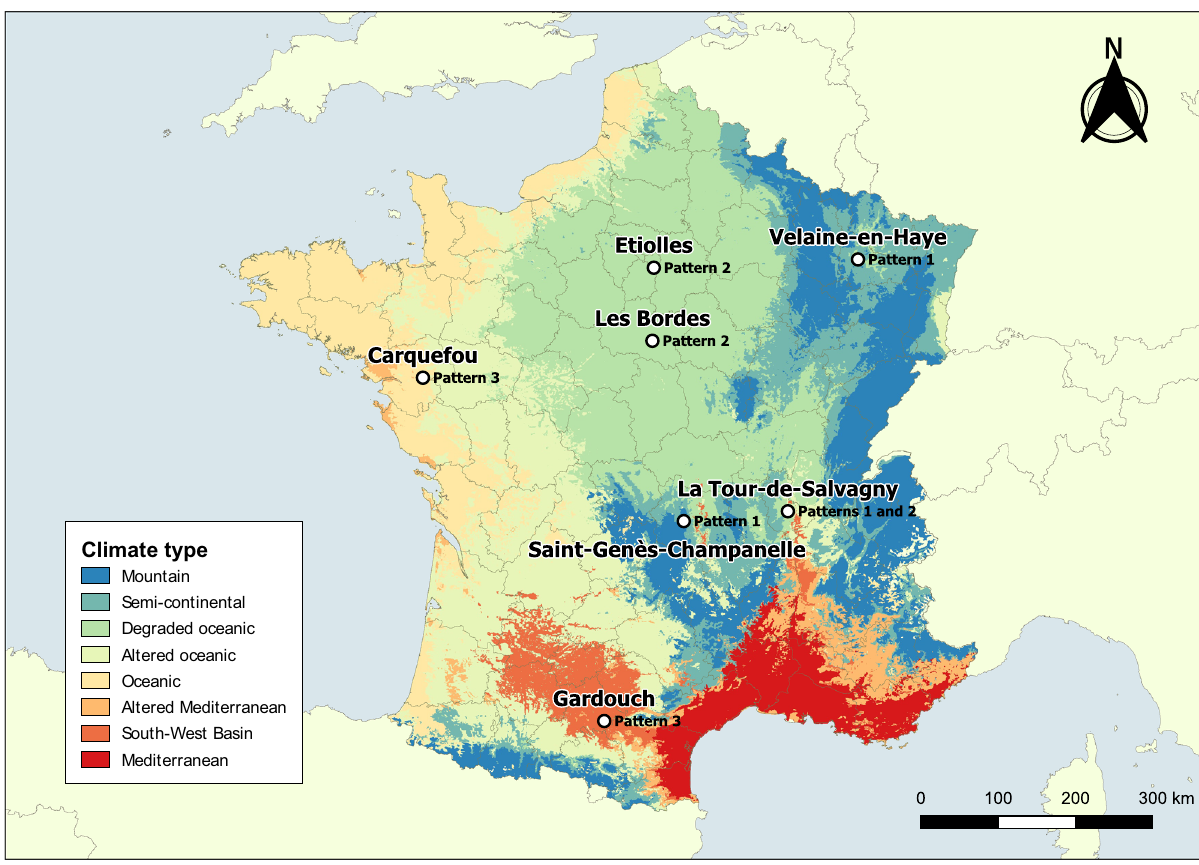
Figure 1. The distribution of tick observatories according to the climatic region types of continental France: (1) Etiolles (degraded oceanic); (2) Velaine-en-Haye (semi-continental); (3) Les Bordes (degraded oceanic); (4) Carquefou (oceanic); (5) La Tour de Salvagny (mixed); (6) Saint-Genès-Champanelle (mountain); (7) Gardouch (south-west basin). Phenological patterns observed at each observatory were also indicated. The map was created using QGIS version 3.8, Zanzibar (https:// www. qgis. org). The climatic region types were previously classified by Joly et al. 29